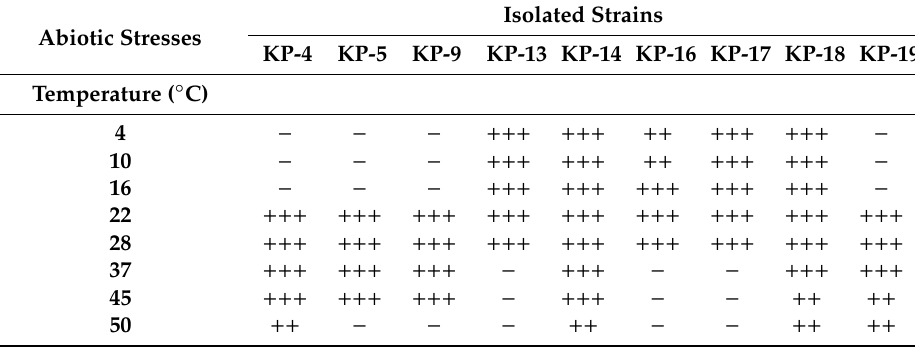
Table 3. Abiotic stress tolerance including to pH, temperature, salinity, and Pb toxicity exhibited by di ff erent